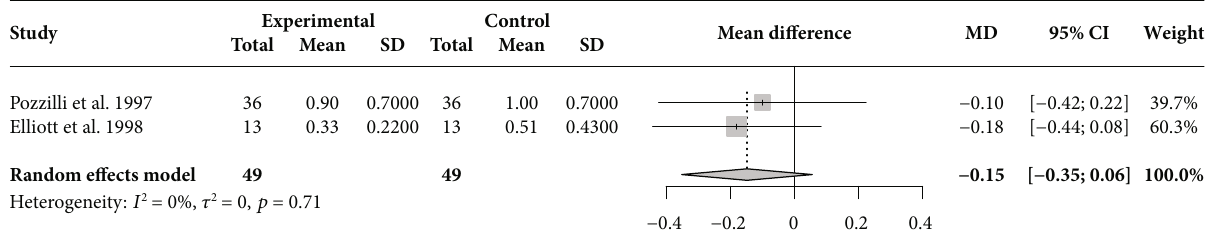
Figure 3: Forest plot of pooled fasting C-peptide level (ng/ml) after the intervention (overall meta-analysis). MD: mean di ff erence; CI: con fi dence